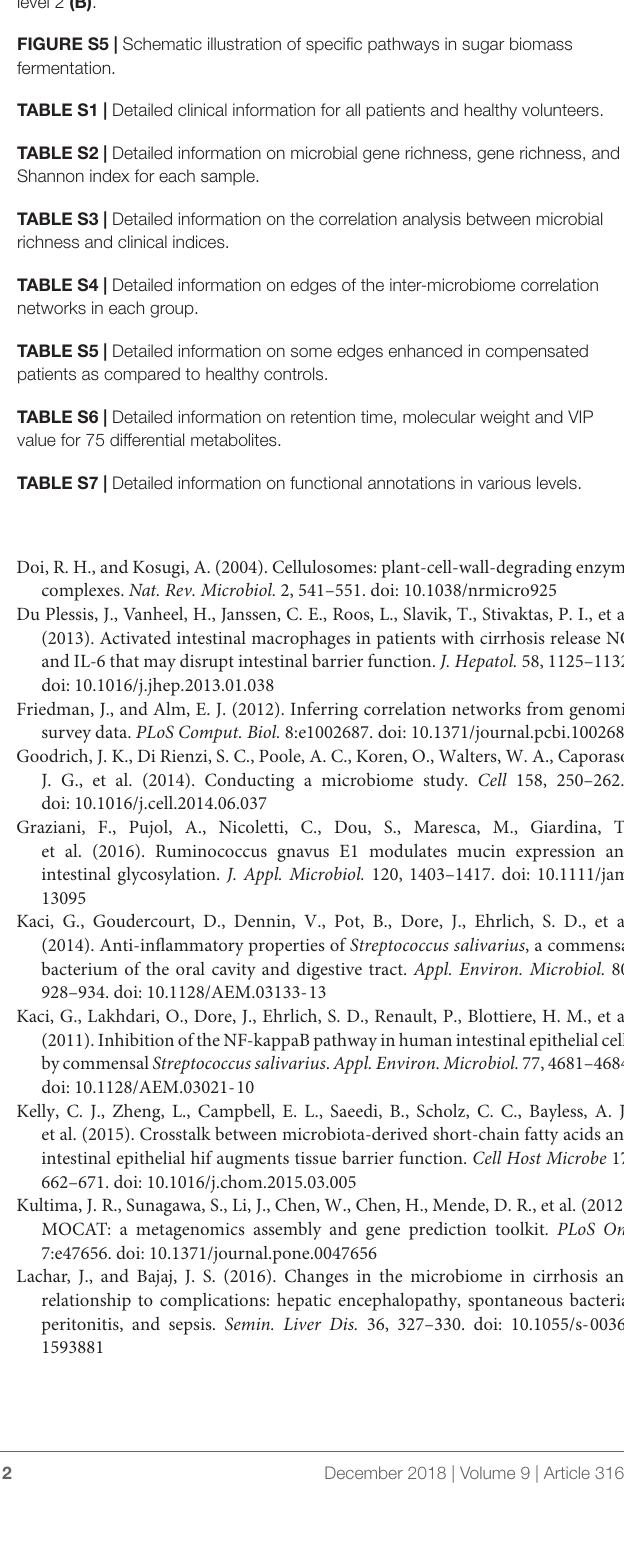
FIGURE S2 | Illustration of the final 30 differential species. (A) Circular representations of taxonomic and phylogenetic trees of the final 30 differential species. (B) Relative abundance of the above 30 species in healthy controls, compensated and decompensated patients based on co-abundant gene clustering analysis.